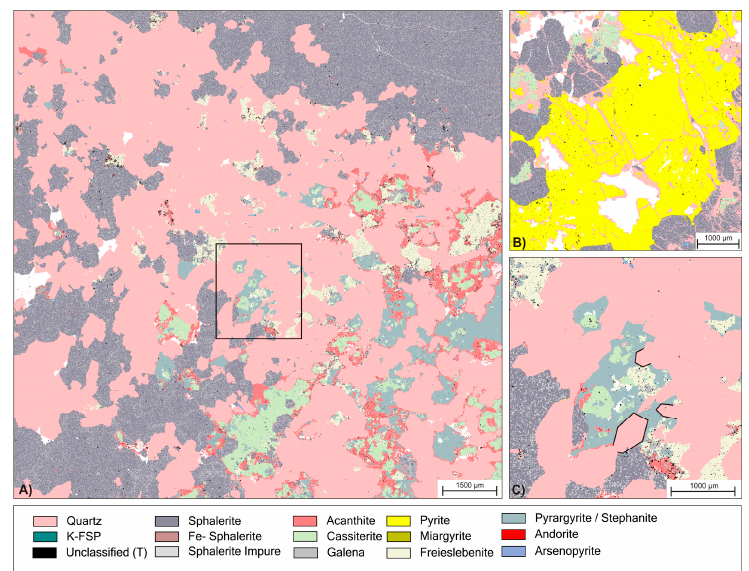
Figure 3. ( A ) Overview phase map of initial ore bearing vein; ( B ) Detailed view of different examples for hydraulic brecciation of sphalerite and pyrite. Fractures has been healed by quartz precipitation; ( C ) Detailed view of box in ( A ) with highlighted examples of idiomorphic textures at grain boundaries of quartz (pink) against an agglomerate of ore minerals.